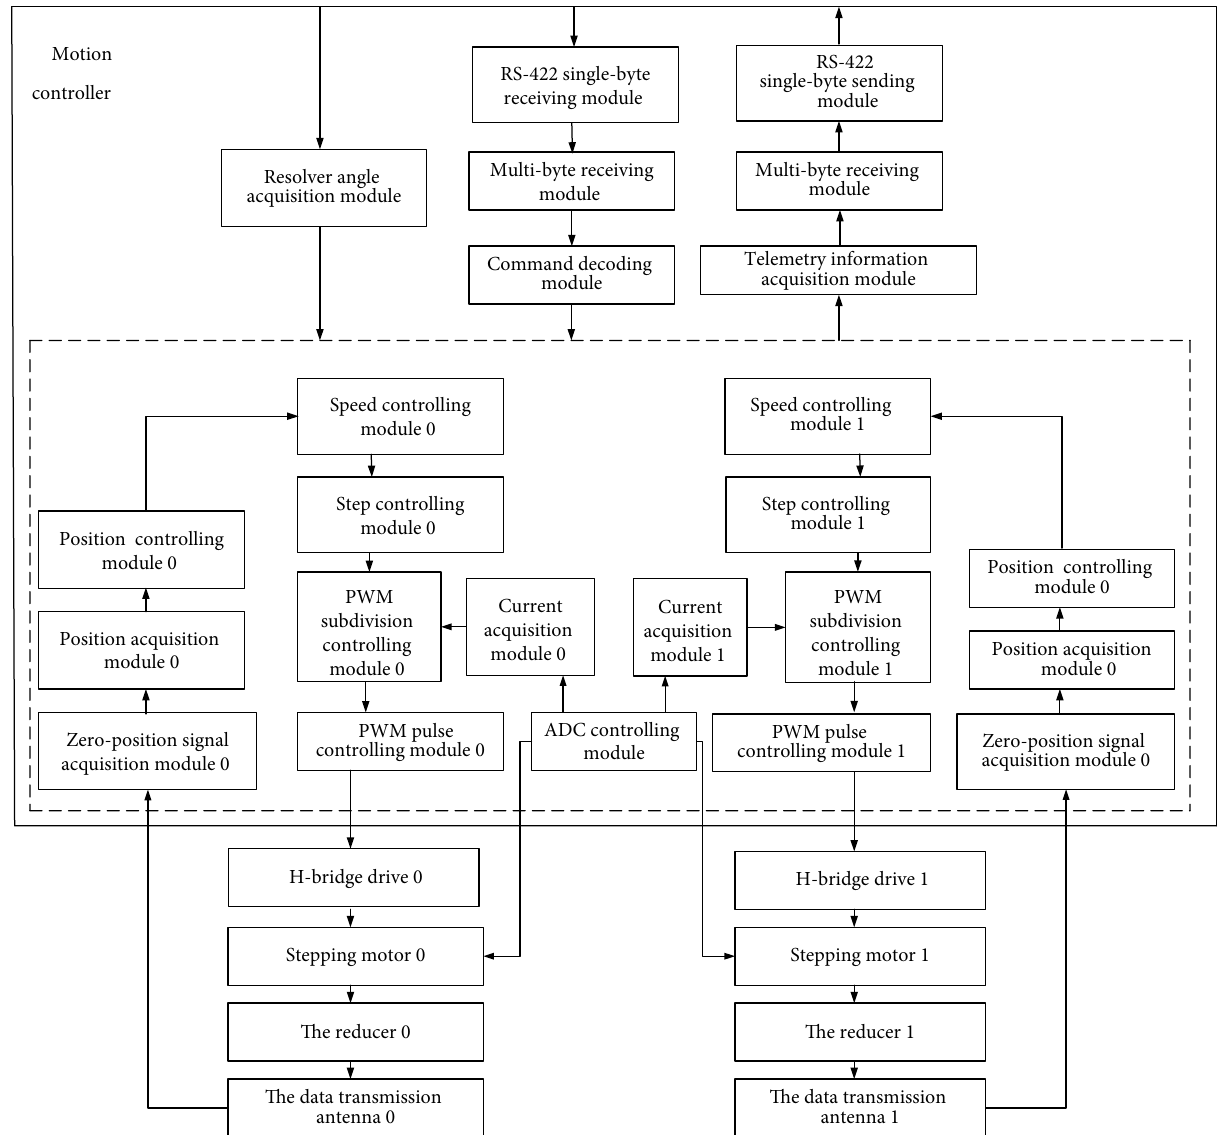
Figure 2: Structural diagram of the motion